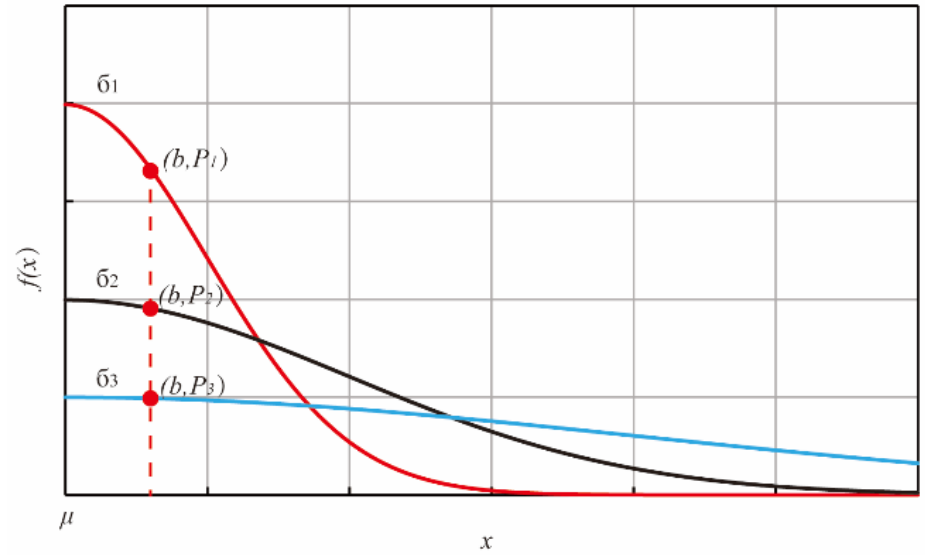
Figure 2. In the angle sorting paradigm, when µ = a and x = b are determined in the normal distribution, σ relates the participant’s haptic angle discriminability. The smaller σ 1 is, the larger the probability density value, which reflects that the participants are more likely to discriminate the smallest angle, that is, the participant has better discrimination of the angle. The larger σ 3 is, the smaller the probability density value, the lower the probability of choosing the smallest angle, and the worse the participant’s haptic angle discriminability.